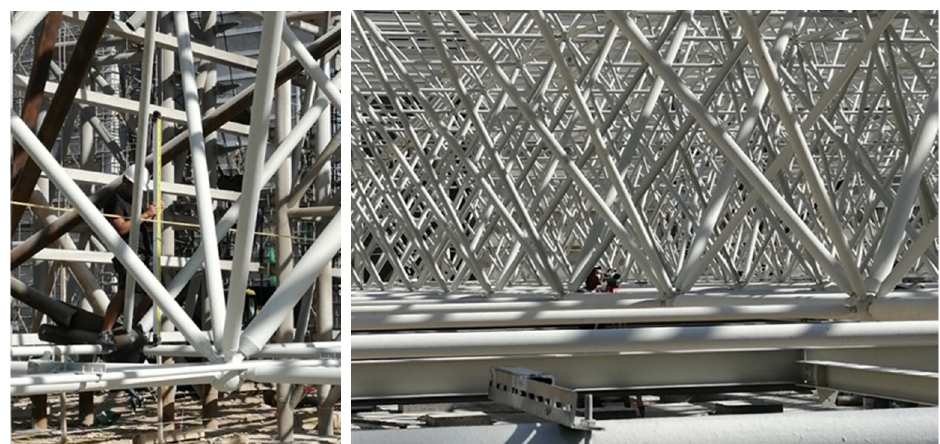
Figure 10. Examples of manual measurement.